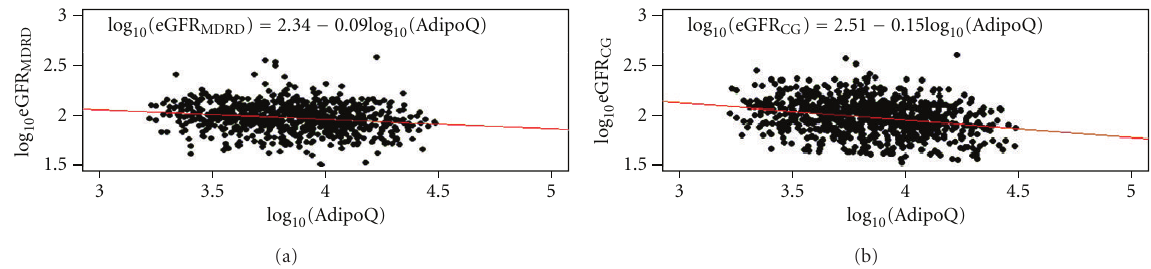
Figure 1: Scatter plots of log transformed eGFR (vertical axis) versus log adiponectin (horizontal axis) in nondiabetic West Africans. (a) Relationship between GFR estimated by MDRD method (eGFR MDRD ) and adiponectin, (b) relationship between GFR estimated by Cockroft- Gault (CG) method (eGFR CG ) and adiponectin. A linear regression line is superimposed on each plot to show the relationship with eGFR.